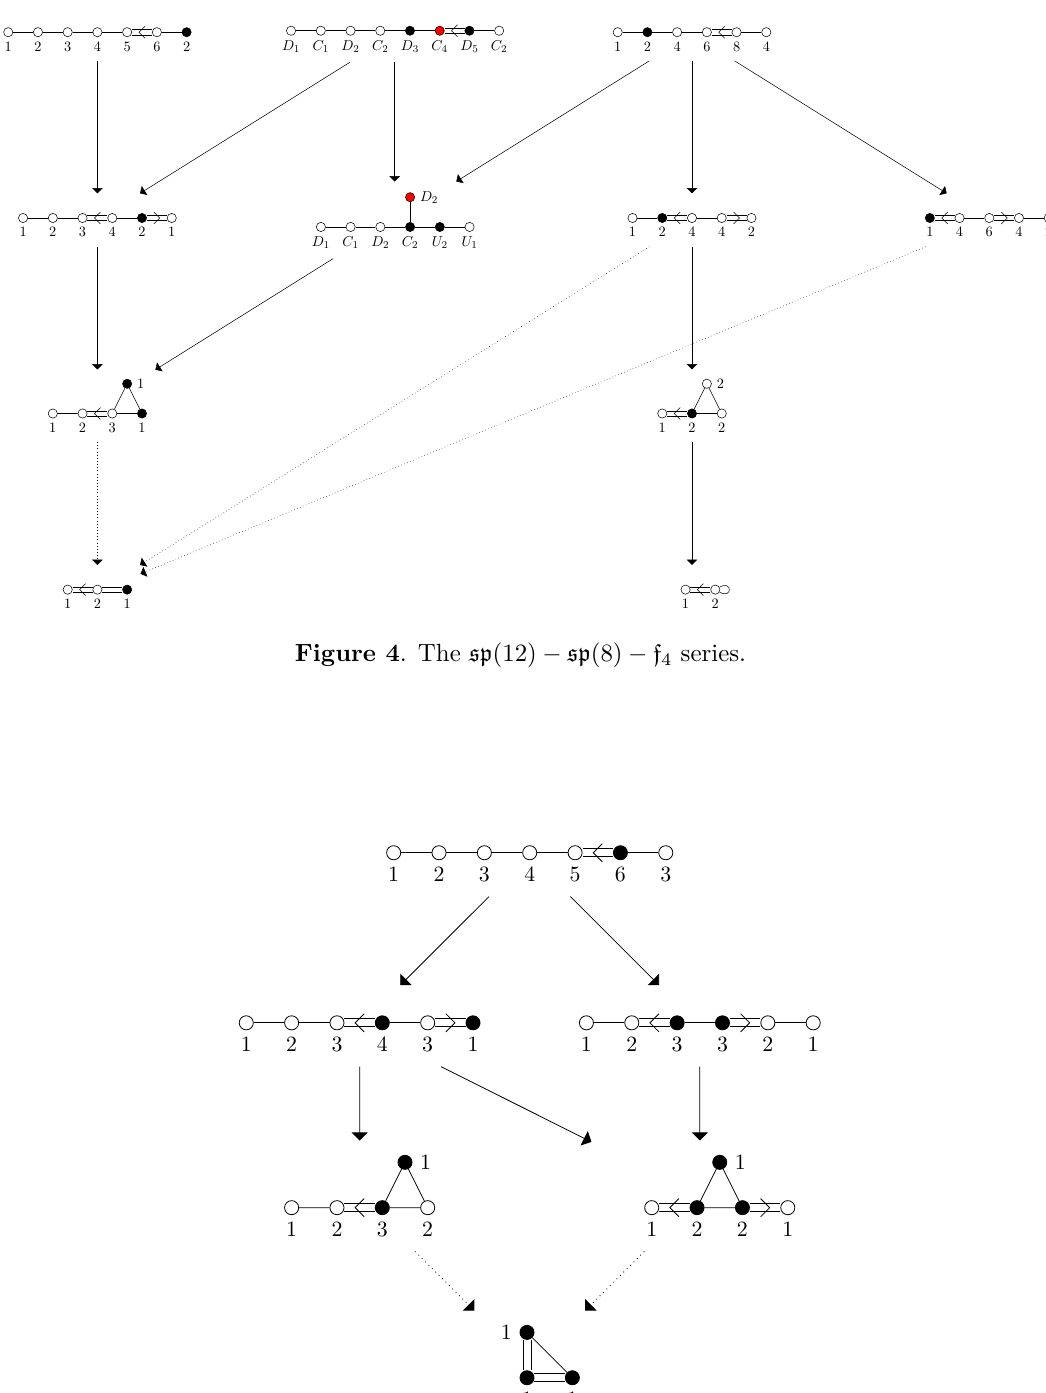
Figure 5 . The su (6)